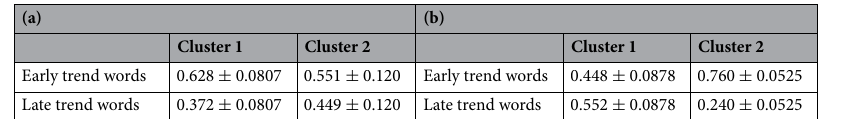
Table 5. Rates of early trend words and late trend words, as defined by Google Trends, within the clusters. Experimental conditions are the same as in Table 4. (a) Results for k -shape 32 . (b) Results for k -shape 32 with the graphical lasso algorithm 22